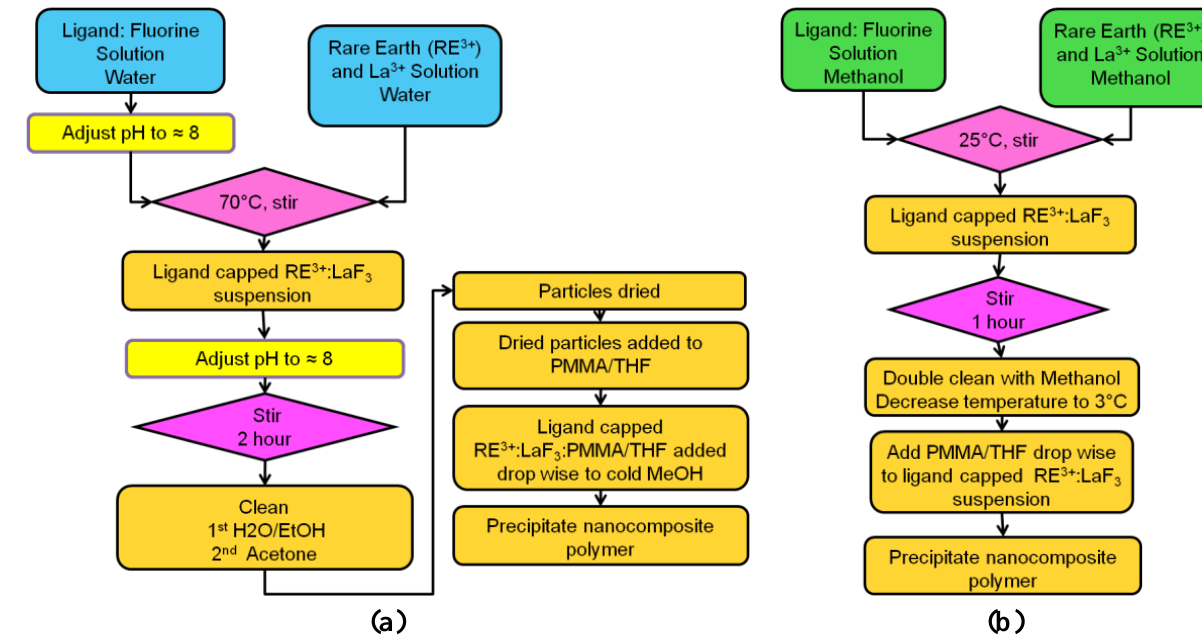
Figure 10. (a) Flowchart nanoparticle synthesis in water; (b) Flowchart nanoparticle synthesis in